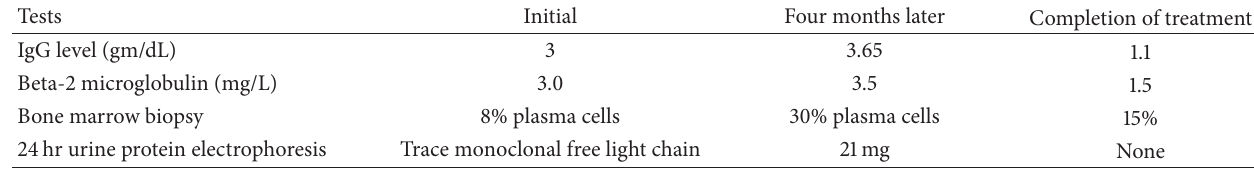
Table 1: Summary of serial lab